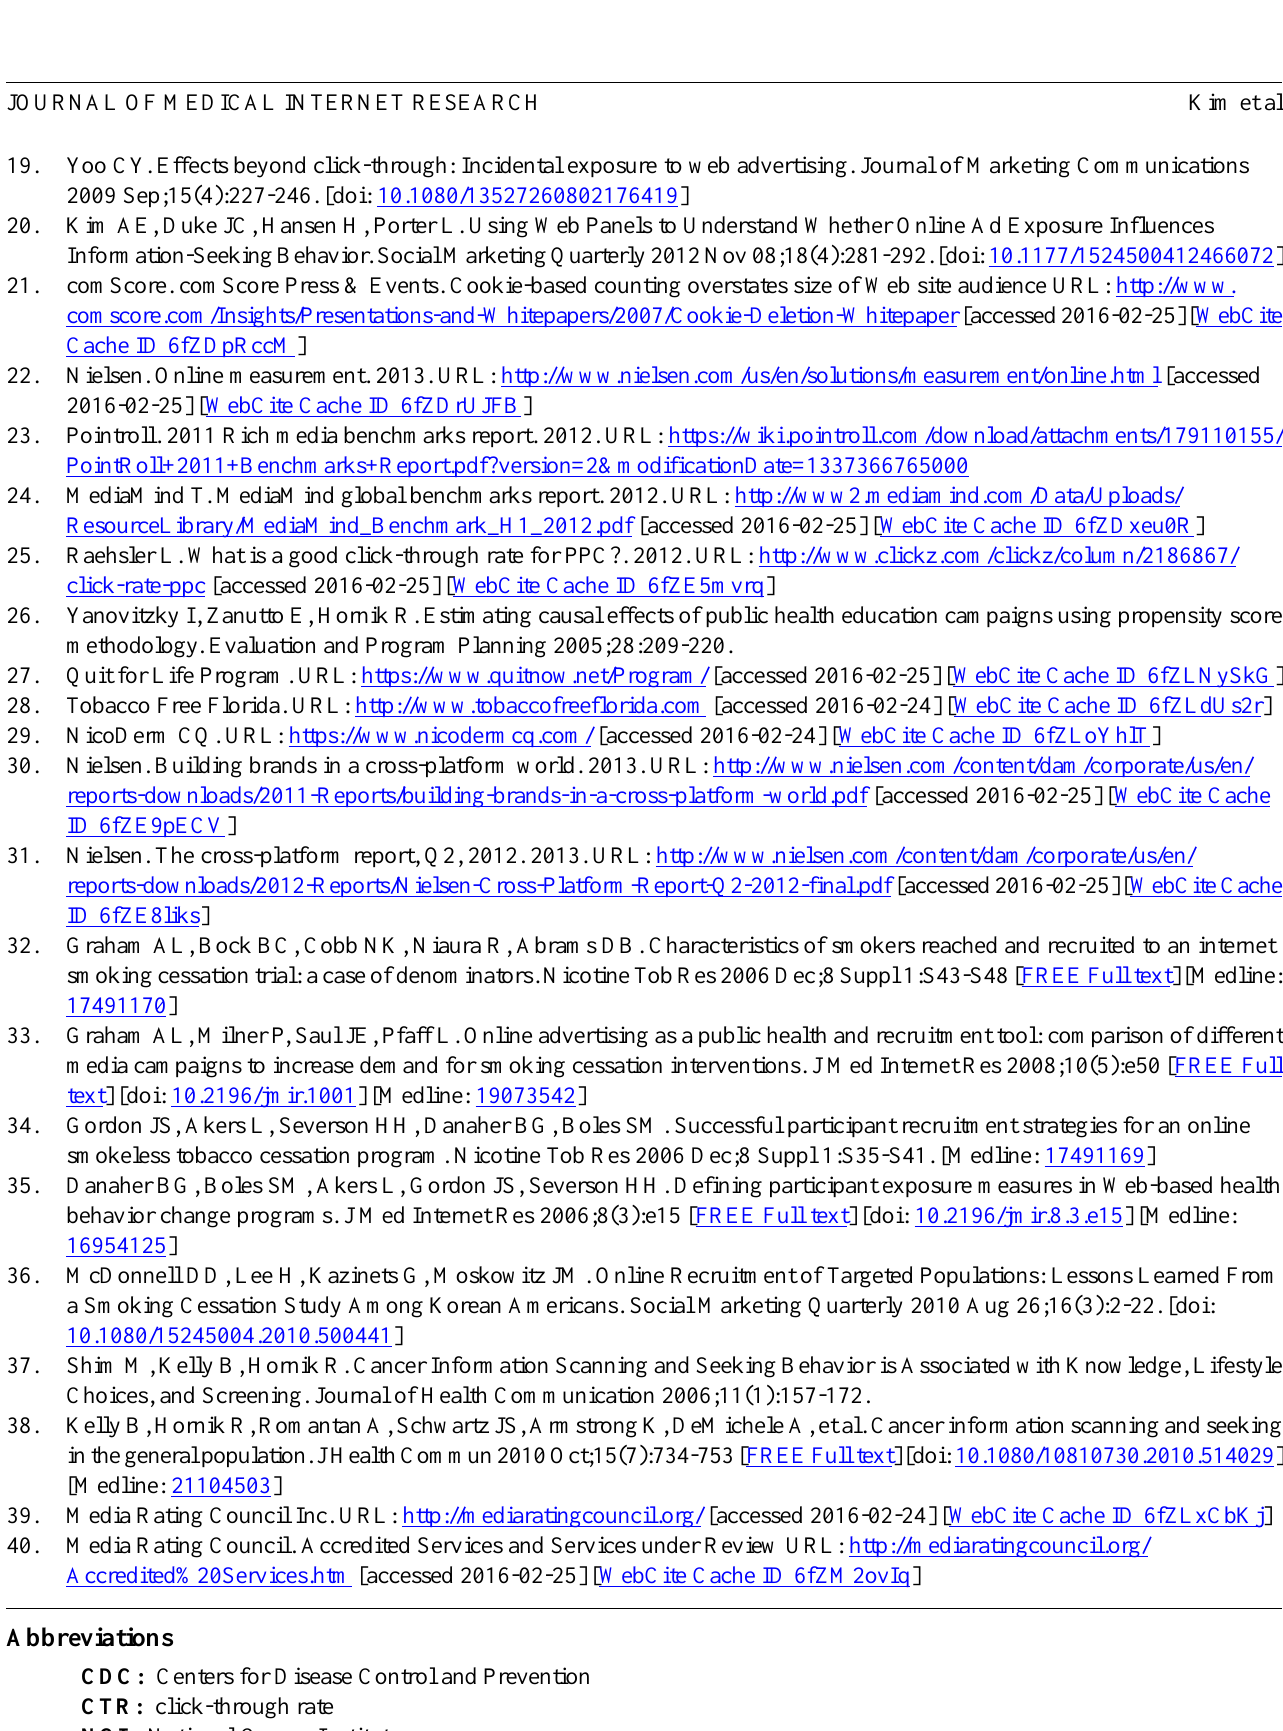
CDC: Centers for Disease Control and Prevention CTR: click-through